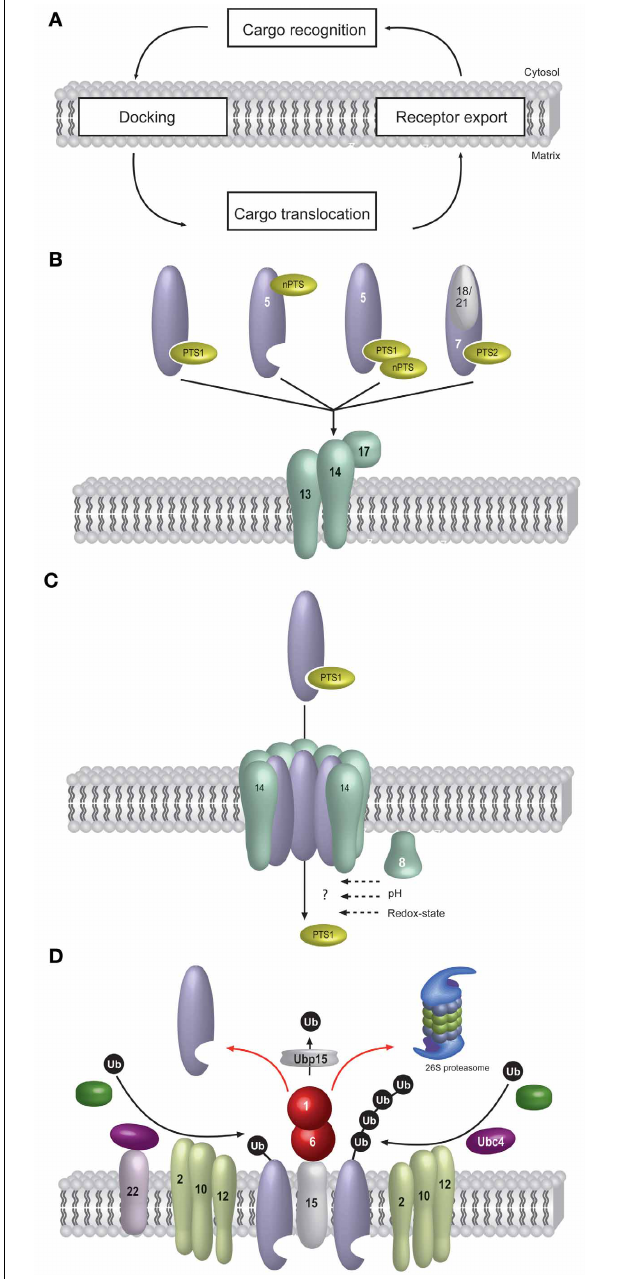
FIGURE 1 | Matrix protein import into peroxisomes. Most principles of peroxisomal protein import are evolutionary conserved. The schematic representation shown here refers to the situation in Saccharomyces cerevisiae . Peroxisomal matrix protein import takes place posttranslationally and requires an elaborate protein import machinery, consisting of peroxisome biogenesis factors, so called peroxins. (A) Another feature of peroxisomal import is the requirement for cycling receptors. The import process can conceptually be divided into cargo-recognition by the receptors in the cytosol, docking of the receptor/cargo-complex at the peroxisomal membrane, cargo translocation and finally export of the receptor back to the cytosol. (B) Cargo-recognition and docking: Proteins harboring a